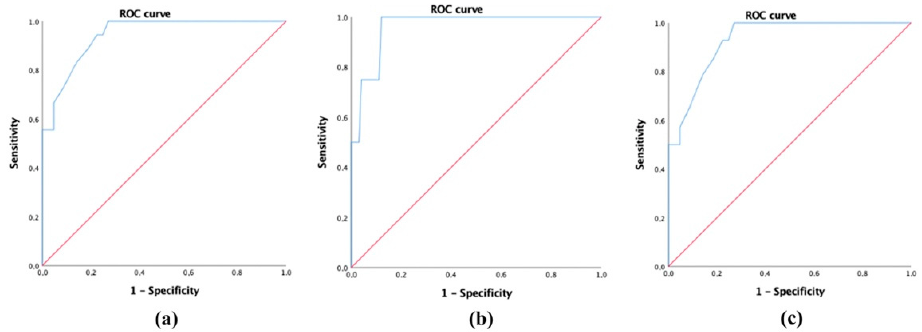
Figure 2. Receiver operating characteristic (ROC) curve to select cut-off points in the Frontal Fibrosing Alopecia Quality of Life Index (FFA-QLI) to split patients into ( a ) mild (< 21), ( b ) severe (> 35), or ( c ) moderately (21–35) impaired quality of life.